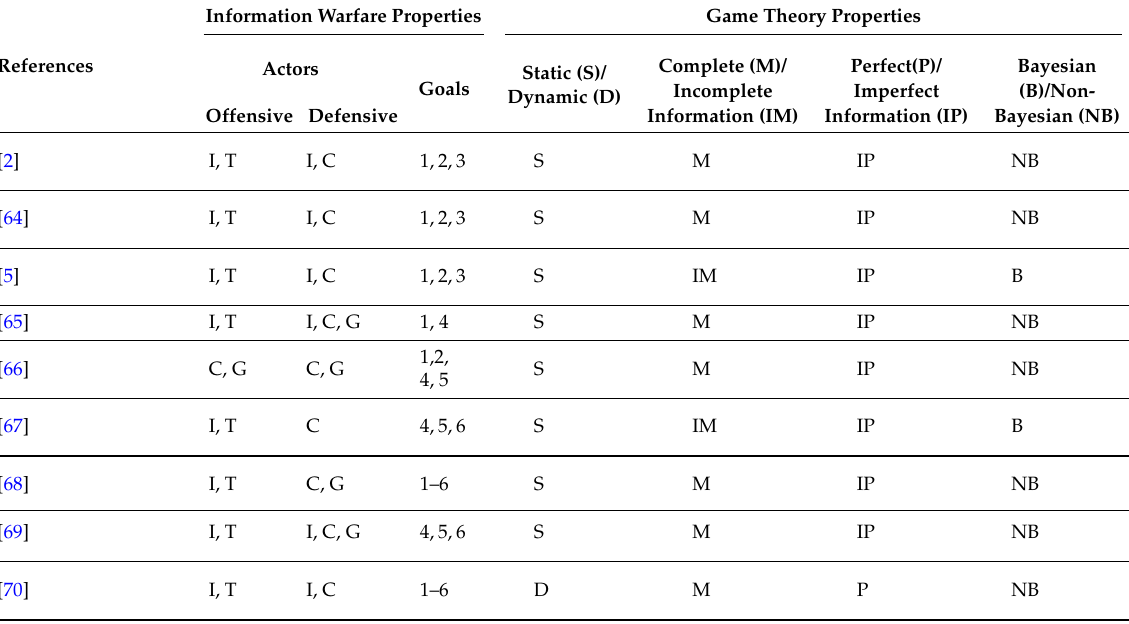
Table 7. List of Economic Information Warfare